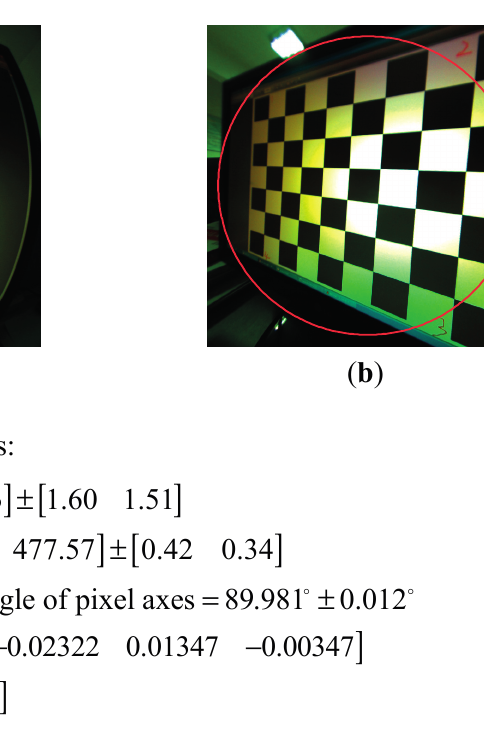
Figure 5. Camera calibration results. ( a ) Original image where the red circle depicts the field of view 110°; ( b ) Undistorted image using the calibration